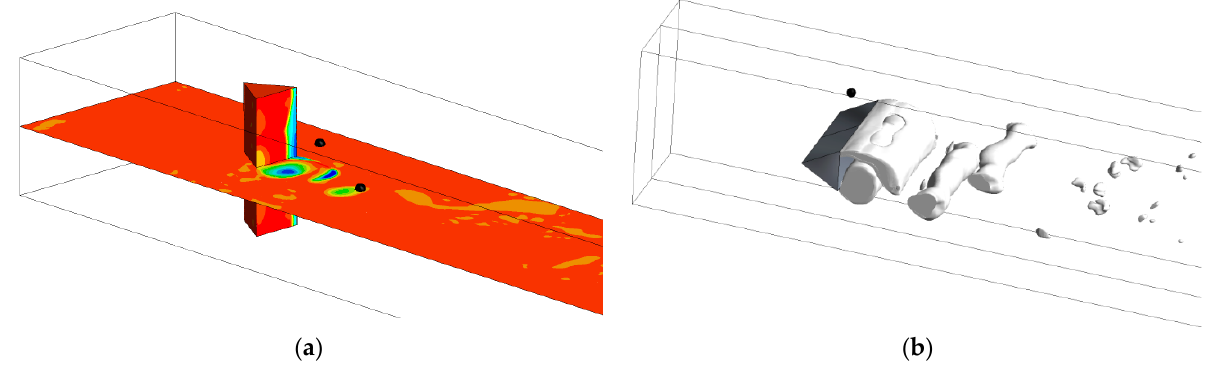
Figure 5. Cavitation at test section mid-plane, σ = 1.676. ( a ) Vector lines; ( b ) distribution f water volume fraction; ( c ) distribution of temperature; ( d ) vortical structures behind the cylinder (Q crite- rion) colored with temperature.